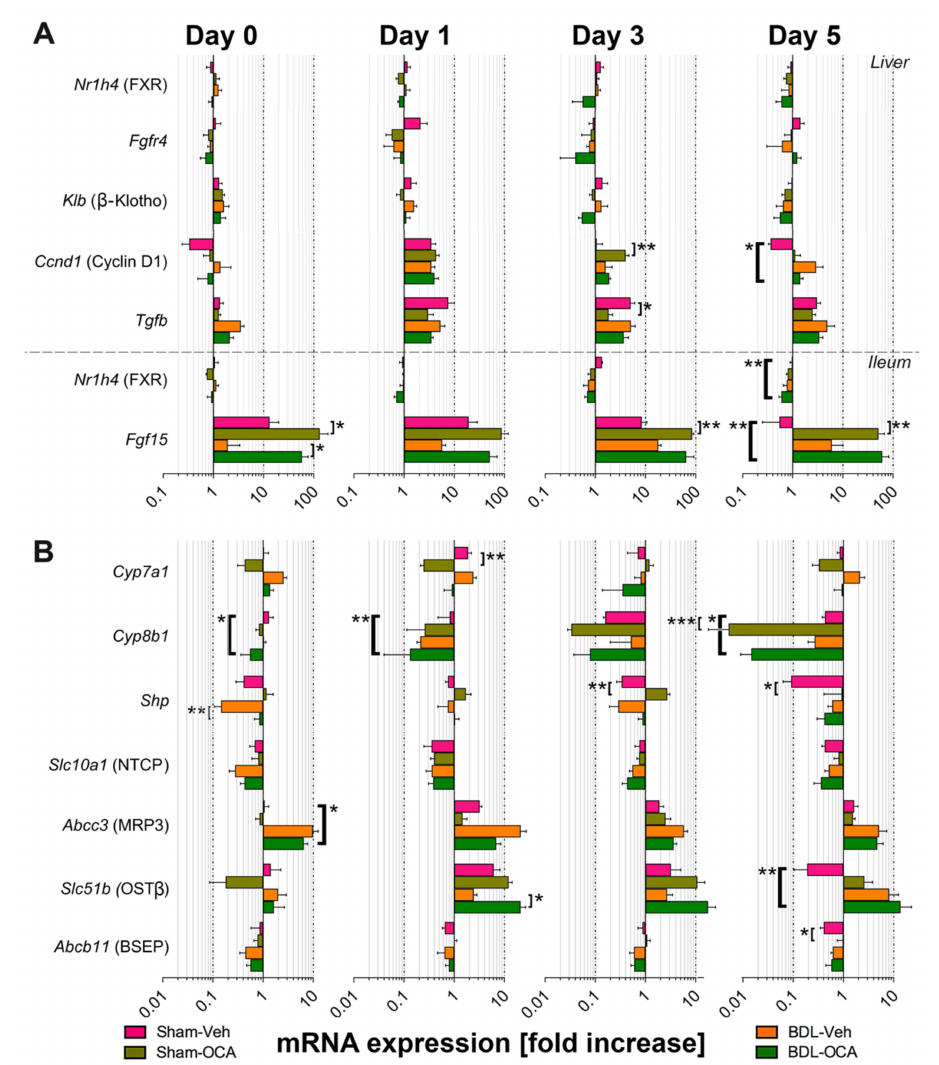
Figure 5. mRNA expression of ( A ) liver and ileum genes involved in liver regeneration and ( B ) liver genes involved in BA homeostasis at the time of PHx ( t = 0 days) and 1, 3, and 5 days after PHx. Transcript levels are expressed relative to the respective mean transcript levels in control rats on t = − 1 day. Significance was assessed using a Kruskal–Wallis test with Dunn’s multiple comparisons test. * indicates p < 0.05; ** indicates p < 0.01; *** indicates p < 0.001. All data points represent mean ± SEM. Veh, vehicle; BDL, bile duct ligation; OCA, obeticholic